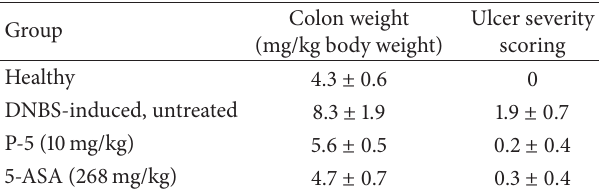
Table 1: The effect of P-5 and 5-ASA on induced colitis, as assessed by measuring colon weight and ulceration